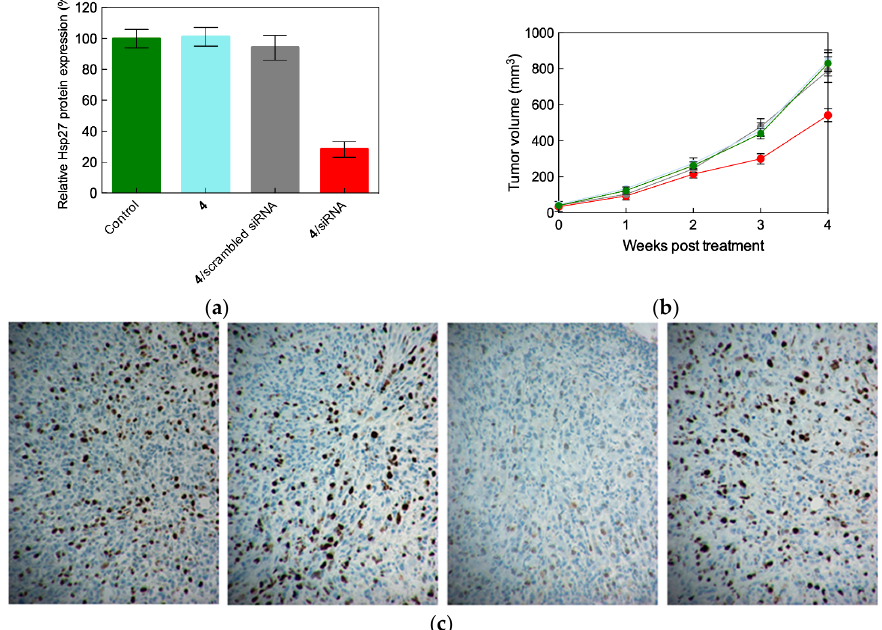
Figure 7. ( a ) In vivo gene silencing achieved by treating nude mice bearing prostate cancer (PC-3) tumors (30–50 mm 3 ) with Hsp27 siRNA delivered by the self-assembling dendron 4 , buffer solution (control), the dendron 4 alone, and a scrambled siRNA/ 4 complex (negative controls). Treatments (3 mg/kg siRNA, N/P = 5) were administered for a period of 4 weeks via intraperitoneal injections (twice per week). ( b ) In vivo inhibition of tumor growth quantified by tumor size and ( c ) antiproliferation activity in tumors assessed by immunohistochemistry in mice treated as described for panel ( a ). Panel ( c ), from left to right: control, 4 alone, 4 /siRNA, 4 /scrambled siRNA. Adapted from [7] with the permission of John Wiley and Sons, 2016.